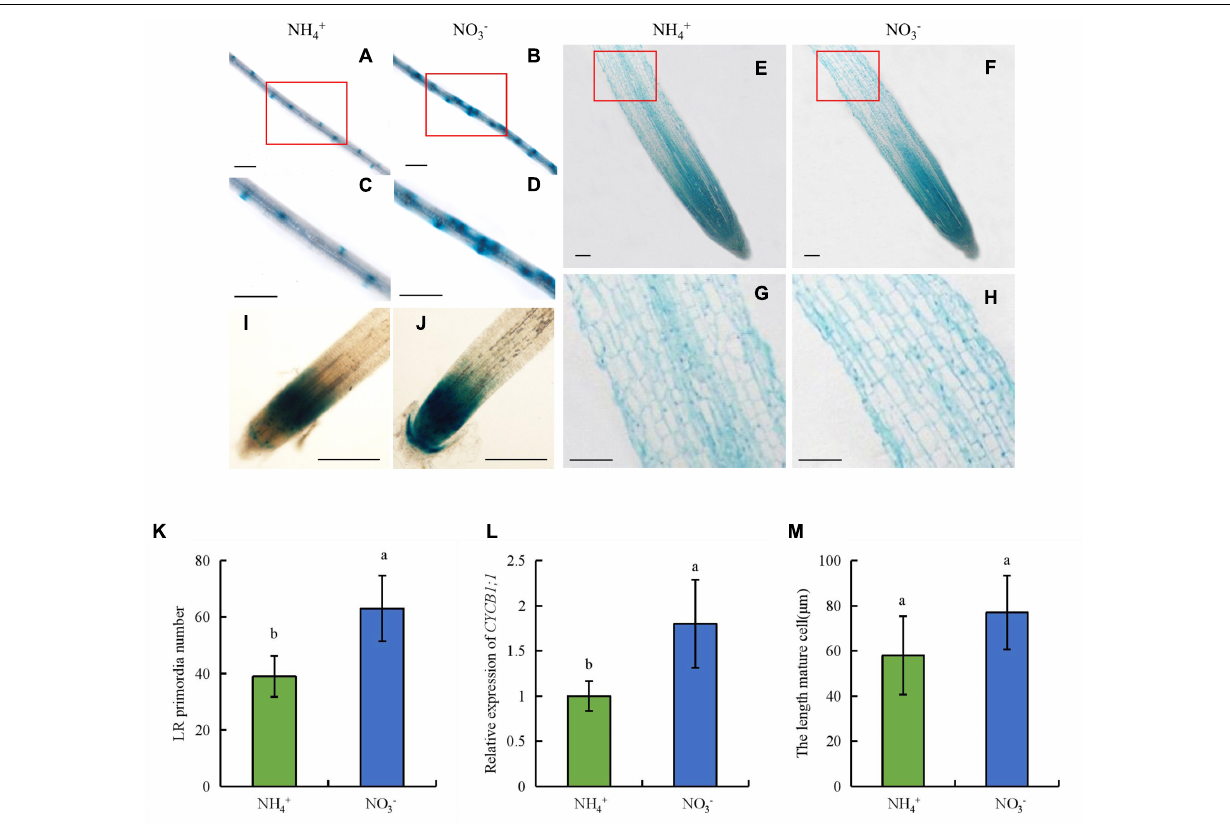
FIGURE 10 | LR primordia and epidermal cell lengths in the maturity zone, expression levels of pCYCB1;1::GUS and OsCYCB1;1 in the meristem zone. Seedlings were grown in hydroponic media containing NH 4 + and NO 3 − for 14 days. (A–D,K) , Lateral root primordia. Bar = 1 mm; (E–H,M) , Epidermal cell length of seminal root. Bar = 100 µ m; (I,J) , Cell cycle activity of the root meristem of seminal root, as monitored by the pCYCB1;1::GUS reporter. Bar = 500 µ m; (L) , The expression of CYCB1;1 gene. Data are means ± SE and bars with different letters indicate significant difference at P < 0.05 tested with